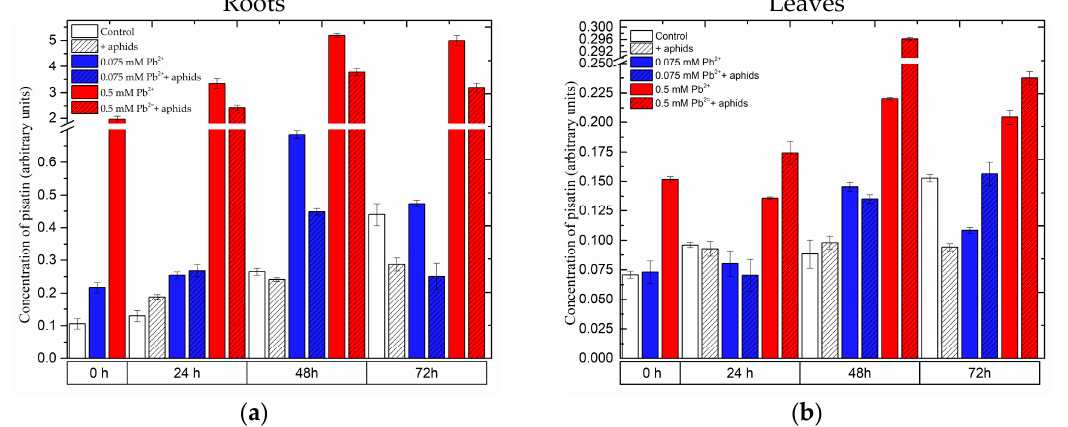
Figure 3. The effect of lead and A. pisum on accumulation of pisatin in roots ( a ) and leaves ( b ) of pea seedlings. The data were obtained in three independent experiments and statistically analysed using ANOVA ( p -values at α = 0.05). Hypotheses on the equality of means were verified by the two-sample t -test. To account for multiple testing, we used the Bonferroni correction (statistically significant differences are shown in Table S1).